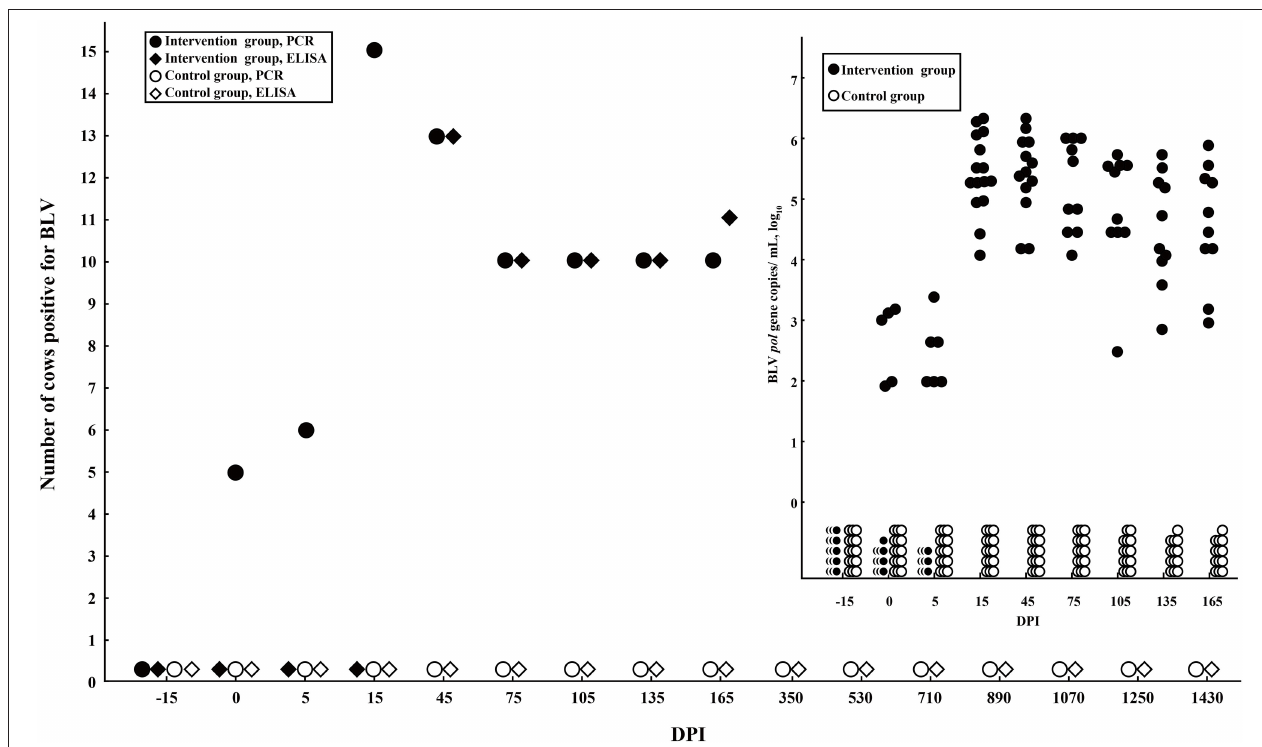
FIGURE 1 | Detection of BLV proviral DNA and anti-BLV antibodies. (Main) BLV FRET-qPCR showed that five and six inoculated cows were detected to be positive at 0 and 5 DPI, respectively. From 45 DPI, all cows in the intervention group were BLV-positive by FRET-qPCR and ELISA. In comparison, all the control cows were free of BLV throughout this study. (Insertion) The copy numbers of BLV pol gene of cows in the intervention and control groups were quantified by